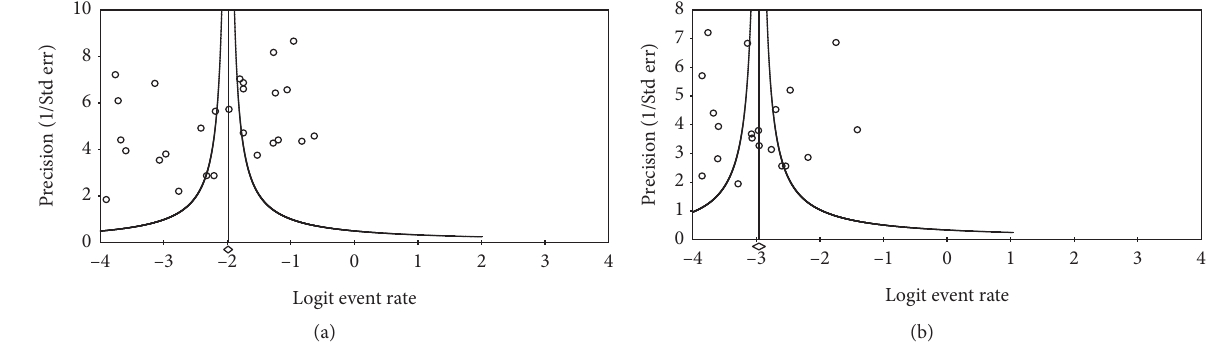
Figure 3: Funnel plot for verification of publication bias in the present meta-analysis. Egger’s test was utilized to verify the presence of publication bias in the meta-analysis for (a) overall incidence of delayed hyponatremia and (b) incidence of symptomatic delayed